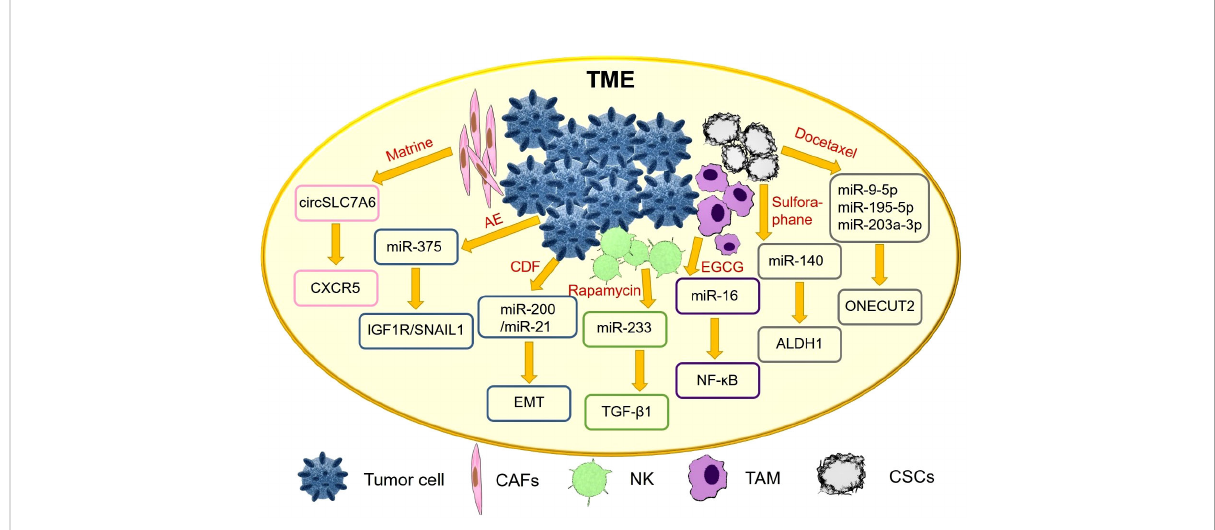
FIGURE 3 Natural drugs improve the TME by regulating exosomal